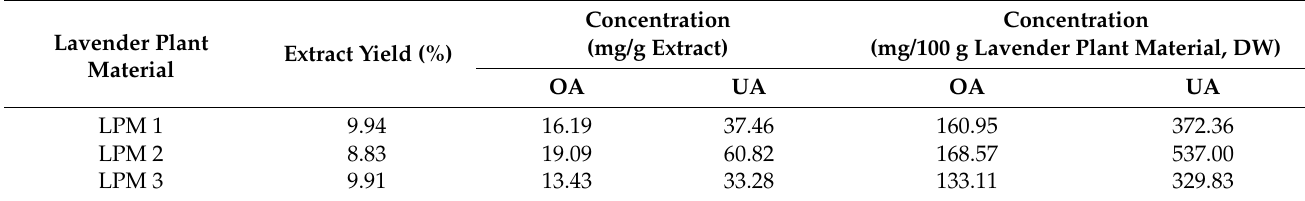
Table 3. The OA and UA content of lavender plant material (DW).